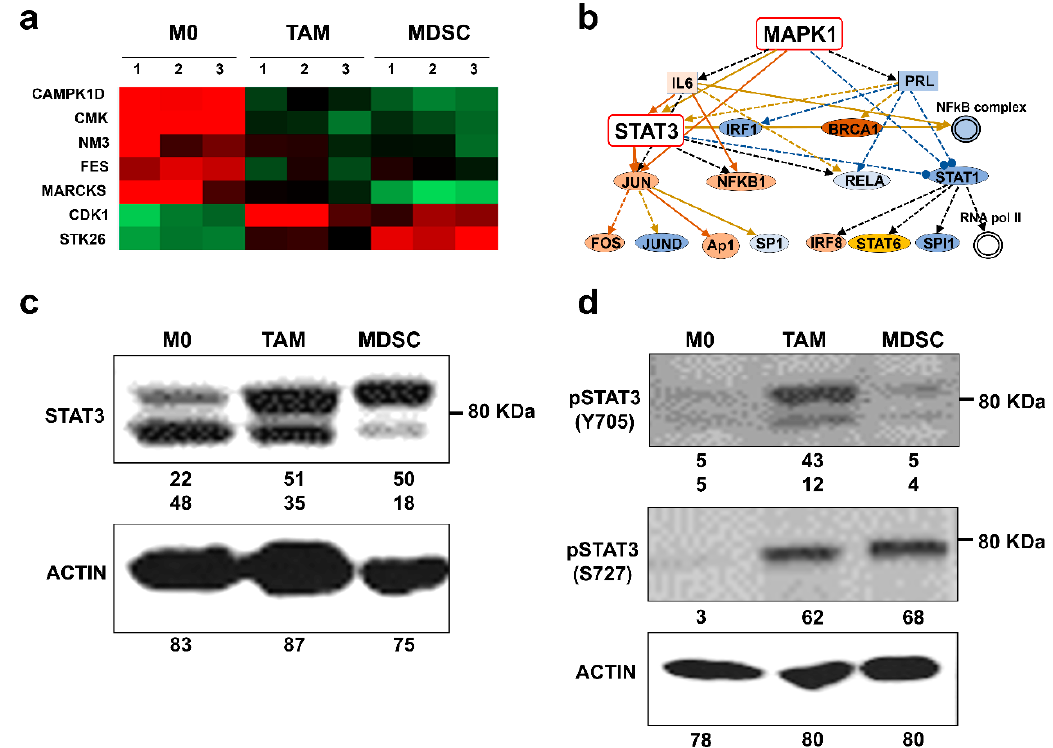
Figure 4. Differentially expressed kinases in ex vivo-differentiated myeloid cells. ( a ) Heatmap of hierarchical clustering representing the differentially expressed kinases identified by proteomics between M0 and tumor-polarized TAMs and MDSCs. ( b ) Functional interactome of kinase networks reconstructed with the Ingenuity Pathways Analysis Tool using the differentially-expressed proteomes in tumor-polarized myeloid cells. Direct interactions/processes are indicated with unbroken arrows. Indirect interactions/processes by dotted arrows. Blocked arrows indicate inhibitory interactions. ( c ) Western blot of STAT3 expression in ex vivo-differentiated myeloid cell types as indicated. STAT3 is resolved in two bands corresponding to distinct phosphorylation states. ( d ) Western blot analyses of phosphorylated STAT3 isoforms as indicated next to the blots, in ex vivo-differentiated myeloid cell types. Westerns were performed in the same membrane after stripping, and equal protein loading was ensured by quantifying protein concentration in lysates using Bradford. The numbers below the western blots indicate band intensities as measured with ImageJ.